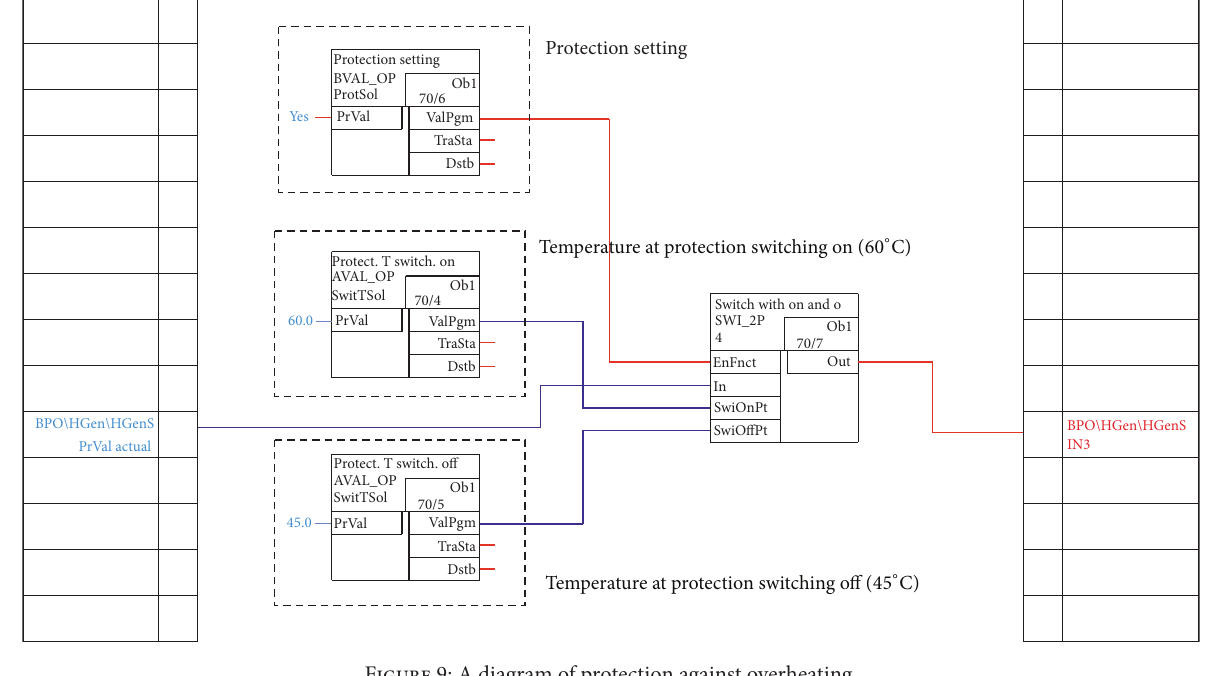
Figure 9: A diagram of protection against overheating.